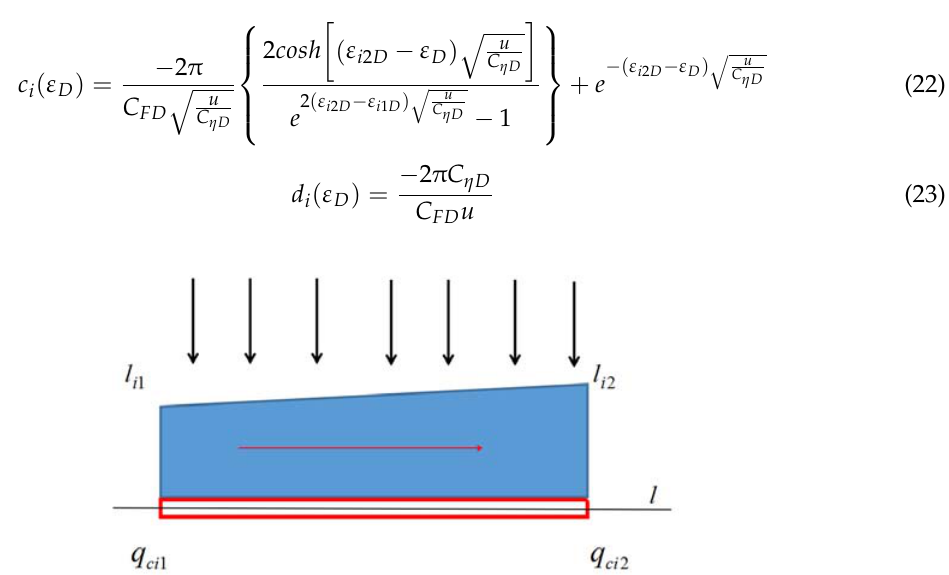
Figure 4. Illustration of fluid flow within i ‐ th fracture segment.